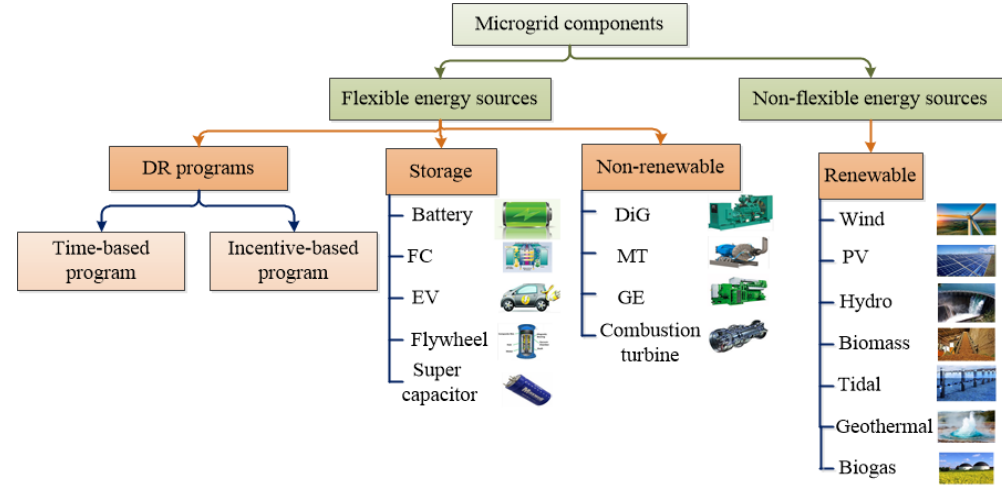
Figure 1. Microgrid components.